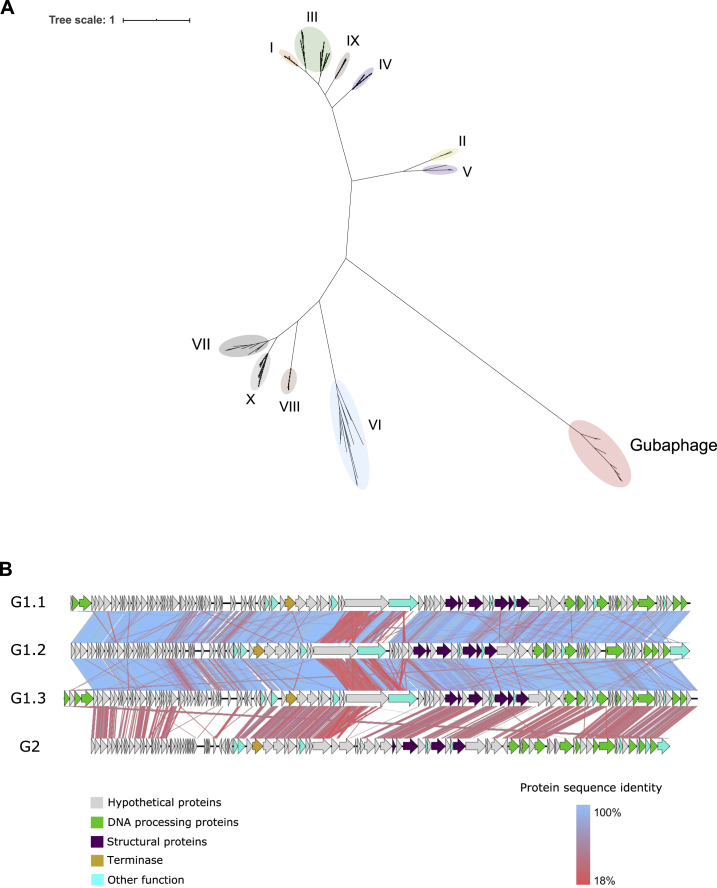
The Gubaphage is a highly prevalent clade in the human gut, related to Figure 5A) Unrooted phylogenetic tree of the large terminase gene from 226 crAss-like genomes and 44 Gubaphage sequences with complete (non-truncated) terminases. Roman numerals correspond to the 10 crass-like genera. The Gubaphage significantly diverged from other crAss-like phages forming a distant clade of its own (red). B) Genome wide comparison across Gubaphage clades. The three main regions in which the Gubaphage genome is divided can be appreciated (segment with a run of hypothetical proteins, DNA processing and structural proteins). There is a high protein sequence similarity among members of the G1 clade compared to those of G2.